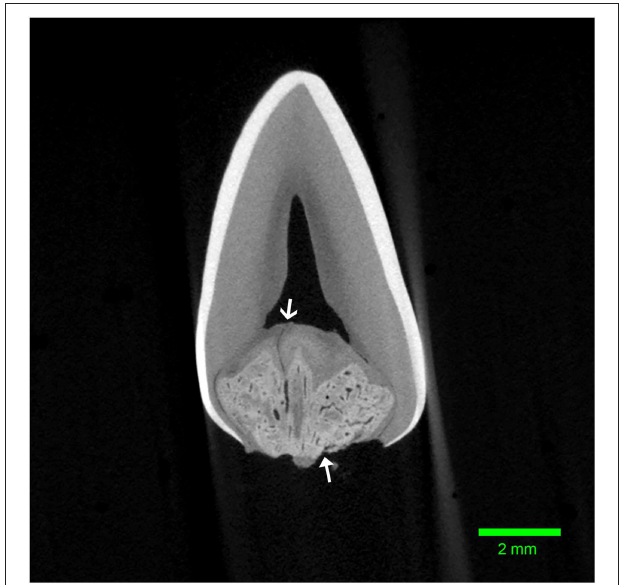
FIGURE 4 | Transverse micro-CT reconstruction through the furcation of the left mandibular first molar tooth from dog 1. Note the corono-apical oriented channel connecting the abnormal tissue to the pulp (open arrow). The entrance to another channel can be seen communicating with the furcational periodontium (closed